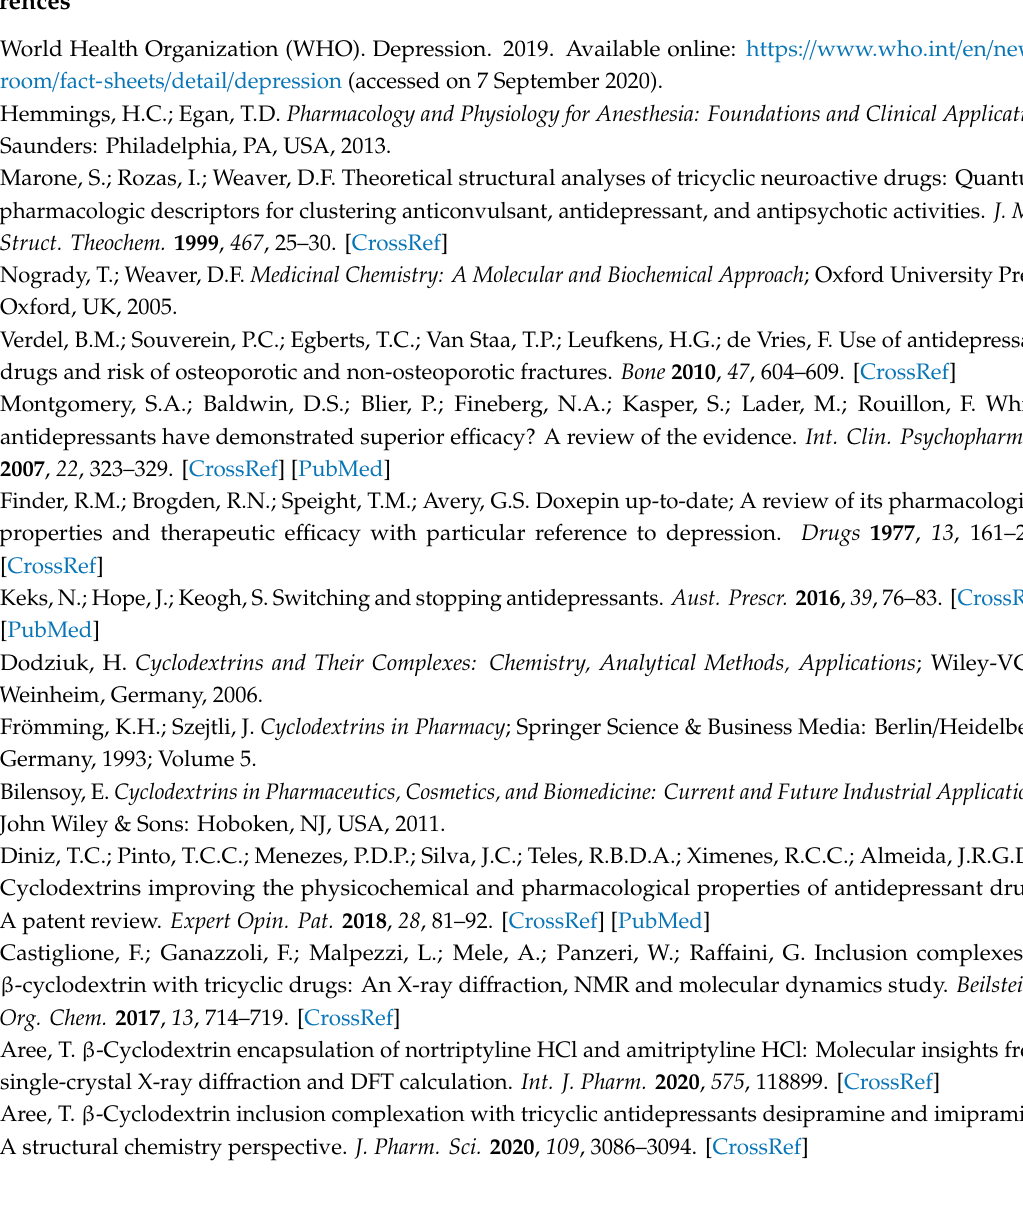
Table S1: Summary of the CD–TCA inclusion complexes characterized by various techniques, Table S2. X-ray single crystal data collection and refinement statistics of 1 and 2, Table S3: Selected geometrical parameters of two β -CD macrocycles of 1and 2, in comparison with those of β -CD–(–)-epicatechin and β -CD · 12H2O, Table S4: Hydrogen bond parameters and π ··· π interactions in β -CD · CPM · HCl · 9.6H2O(1), Table S5: Hydrogen bond parameters and π ··· π interactions in β -CD · DXP · HCl · 0.7EtOH · 11.3H2O(2), Table S6: Structural parameters of CPM, DXP, DPM, IPM, AMT and NRT in free HCl salt form and in complex with proteins, Table S7: Hydrogen bond parameters in β -CD–CPM (4 modes) and β -CD–DXP (2 modes) inclusion complexes from DFT full-geometry optimization, Figure S1: Inclusion complexes of (a) β -CD–CPM(Cl on C3), (b) β -CD–CPM(Cl on C7) with Cl inside and outside the β -CD cavity, and (c) β -CD–E / Z-DXP, derived from DFT complete-geometry optimization in the gas phase. Crystallographic data of 1 and 2 have been deposited at the Cambridge Crystallographic Data Centre (CCDC) under respective reference numbers 2011745 and